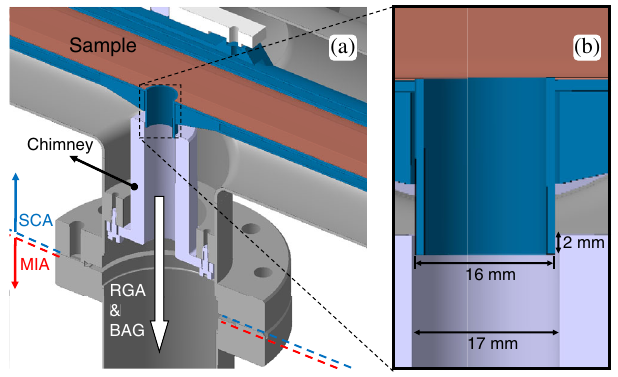
FIG. 5. Descriptive 3D model of the chimney connection, between the MIA and the inner part of the sample under study at the